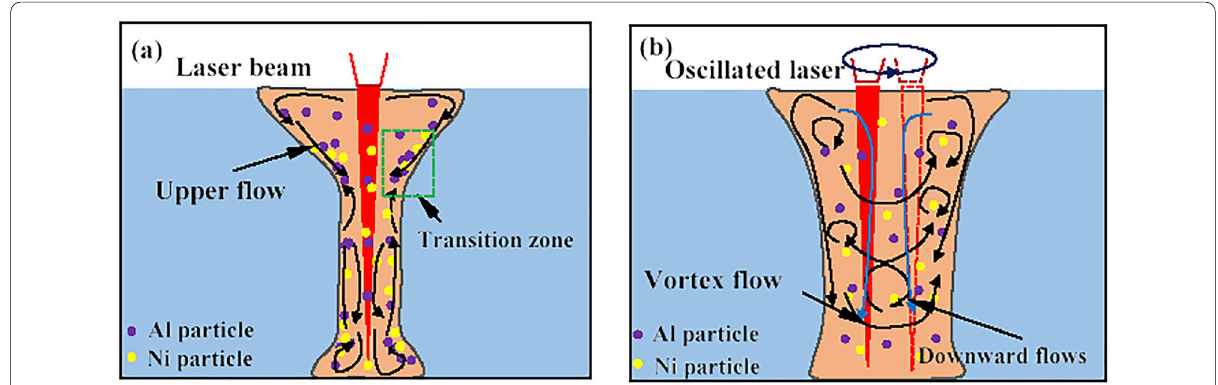
Figure 8 Schematic illustration of the elemental flow: a A osc